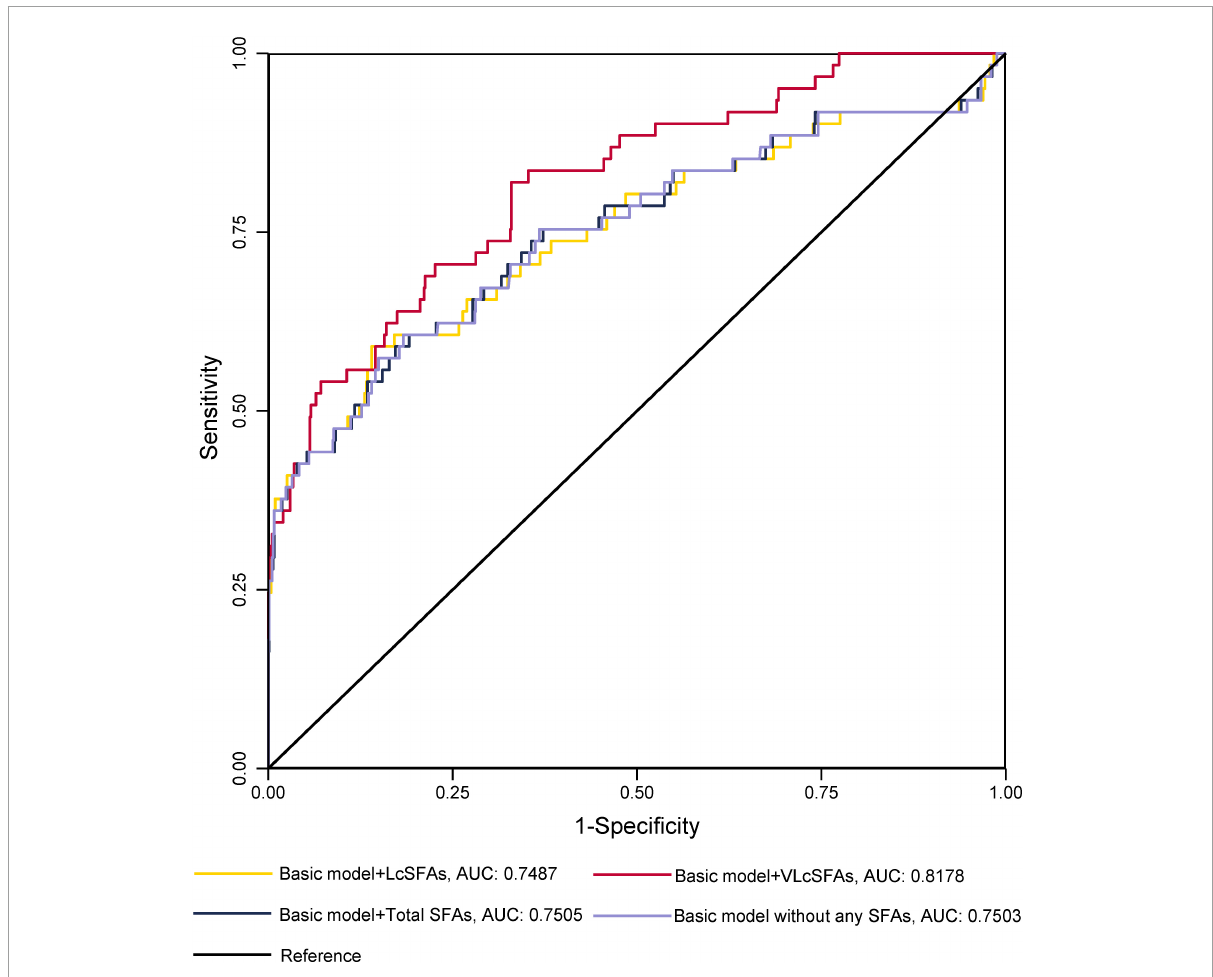
FIGURE1 Receiver operating characteristic curves without or with the addition of a SFA category for GDM diagnostic models in cross-sectional study participants.